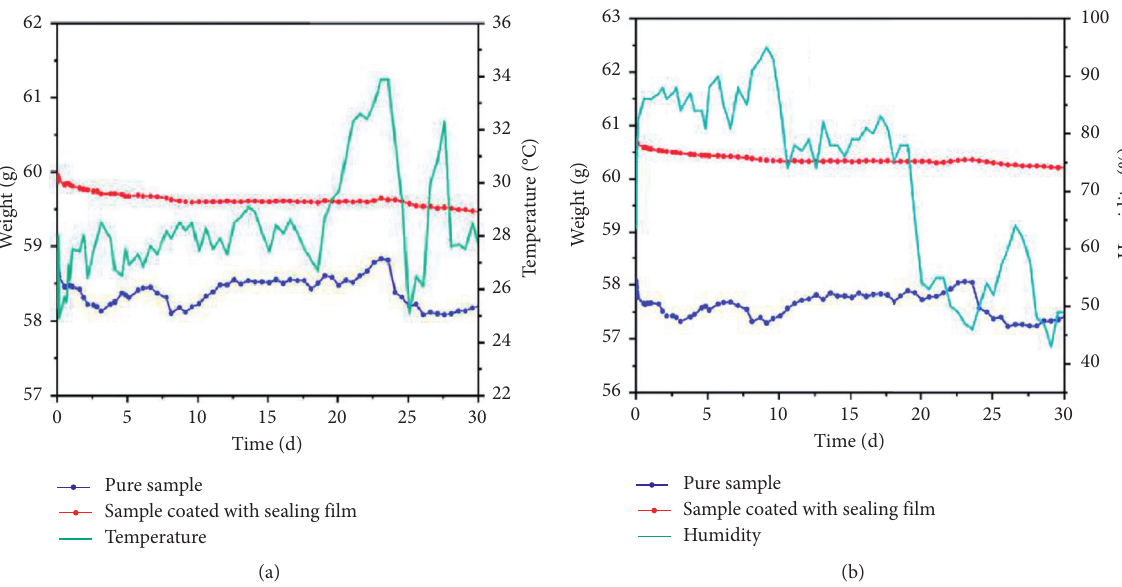
Figure 15: Plot of water vapor transmission as a function of (a) temperature and (b) humidity of the samples with and without sealing